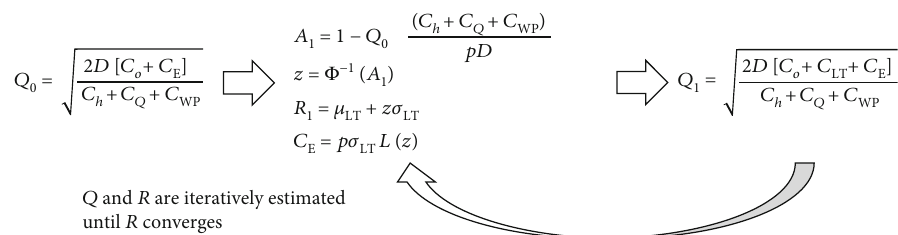
Figure 5: Estimation process of the inventory control policy under the adapted ( Q , R ) model with four SD cost variables (own work).